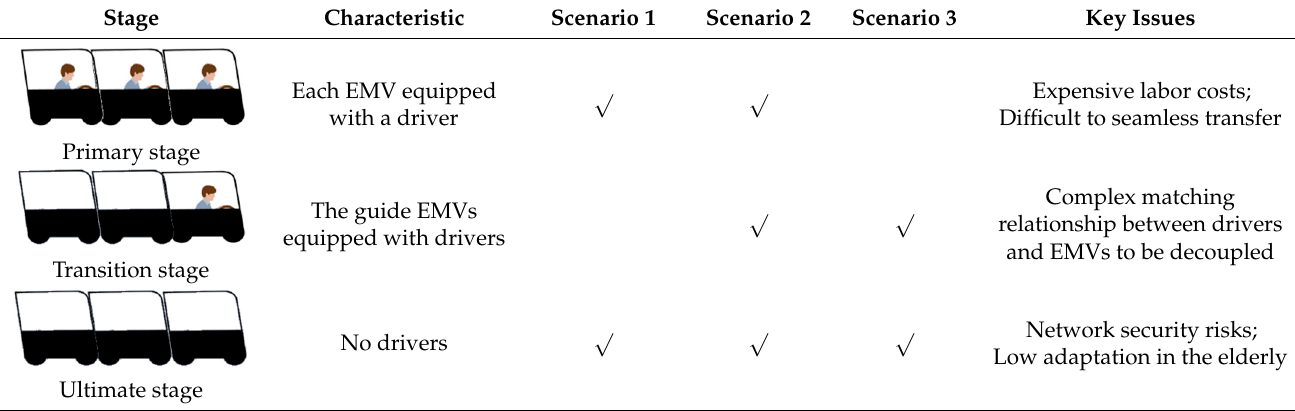
Table 1. Key issues and case applicability in three development periods of IPTS.